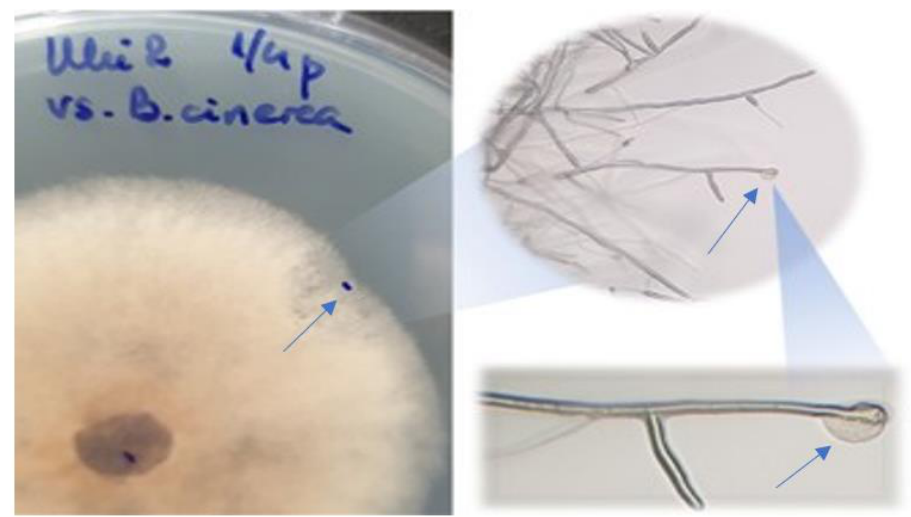
Figure 11. Fungal cell lysis of Botrytis cinerea when exposed to EO 2 basil at C 4 = 25% in the emulsion (the arrow indicates cytoplasm leaks).